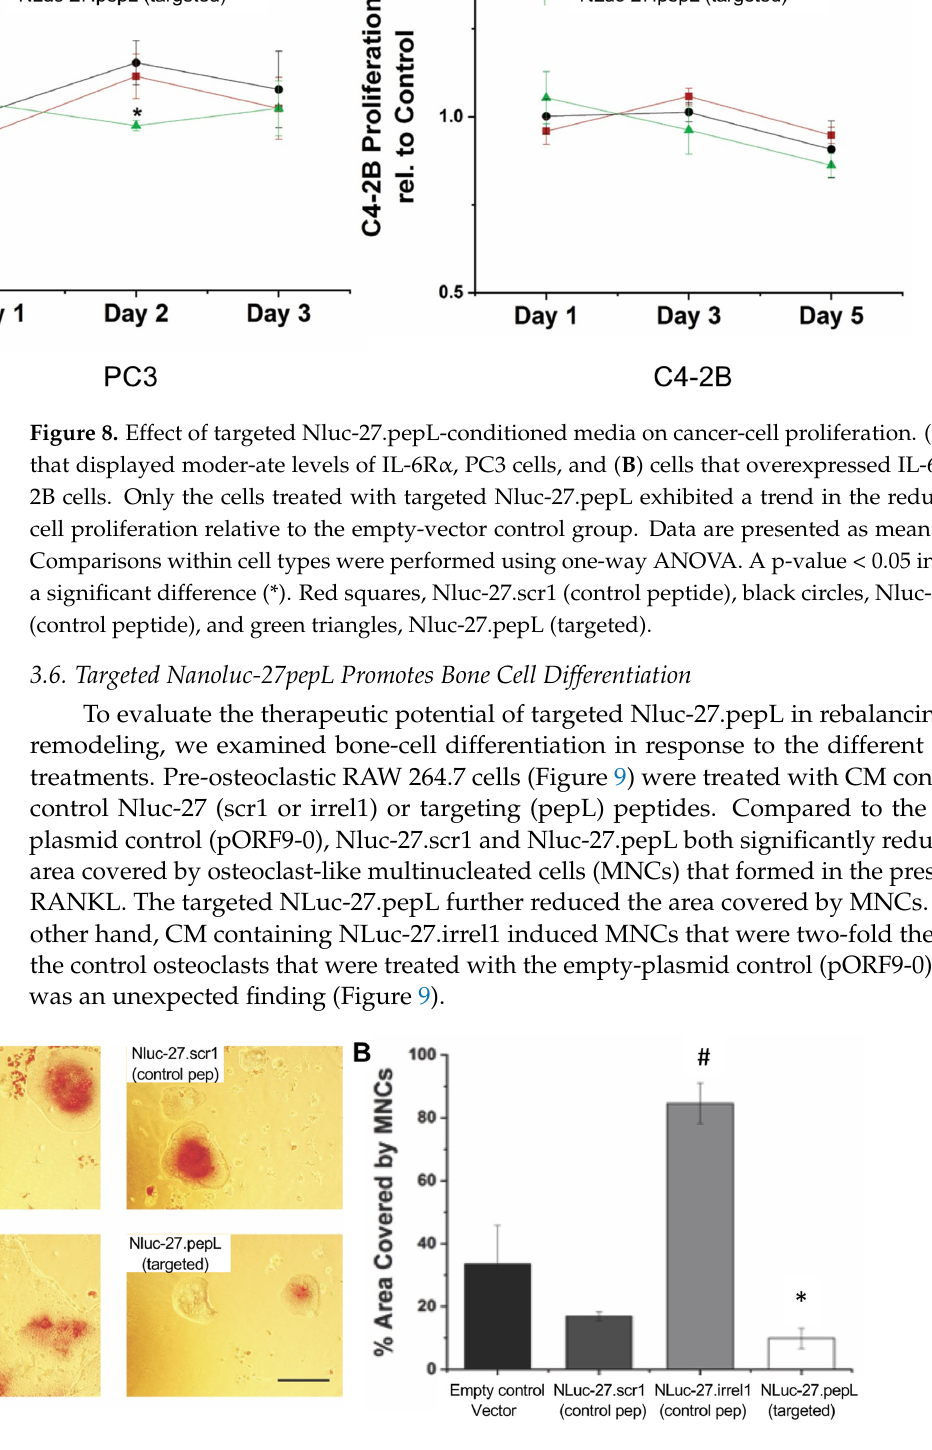
Figure 9. Targeted Nluc-27.pepL inhibits RANKL-mediated osteoclast formation in pre-osteoclastic cell line RAW 264.7. ( A ) NLuc-27.pepL significantly reduced the size of osteoclasts formed compared to the control empty vector or Nluc-27.scr1 (*, p < 0.05). ( B ) The Nluc-27.irrel1 control induced significantly larger multinucleated cells (MNCs) compared to the other three groups (#, p < 0.05). Comparisons were performed using unpaired t -test. Scale bar 100 µm.